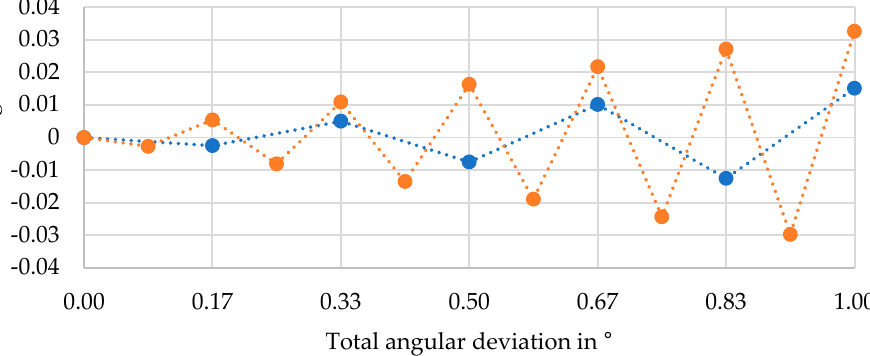
Figure 3. Position changes for reflections in a polygon with deviations in the corner angles. Blue: hexagon, orange: dodecagon.